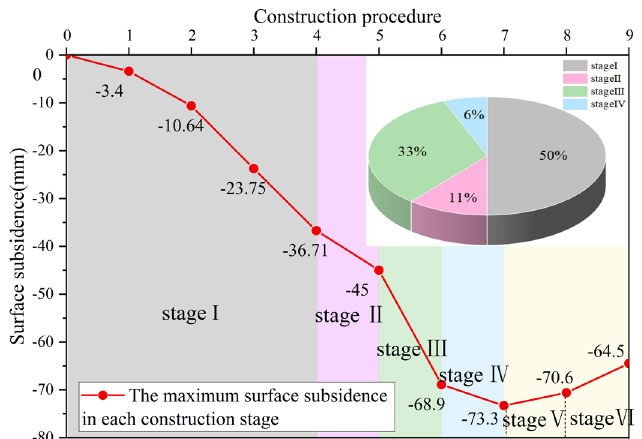
Figure 12. Relationship between surface subsidence and construction steps.